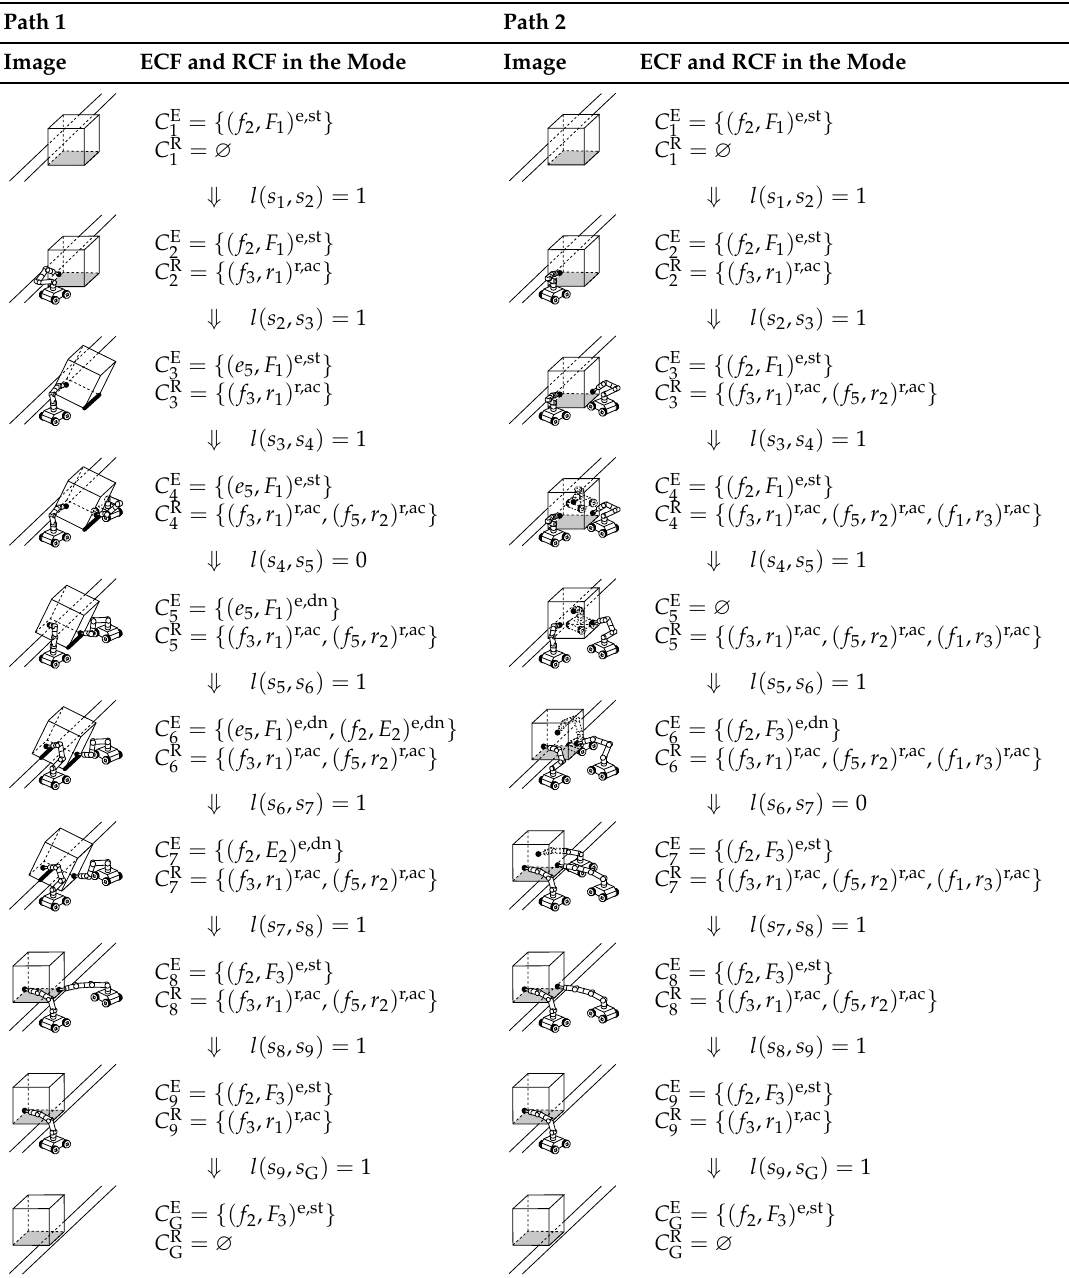
Table 4. Two paths of the manipulation paths which minimized the